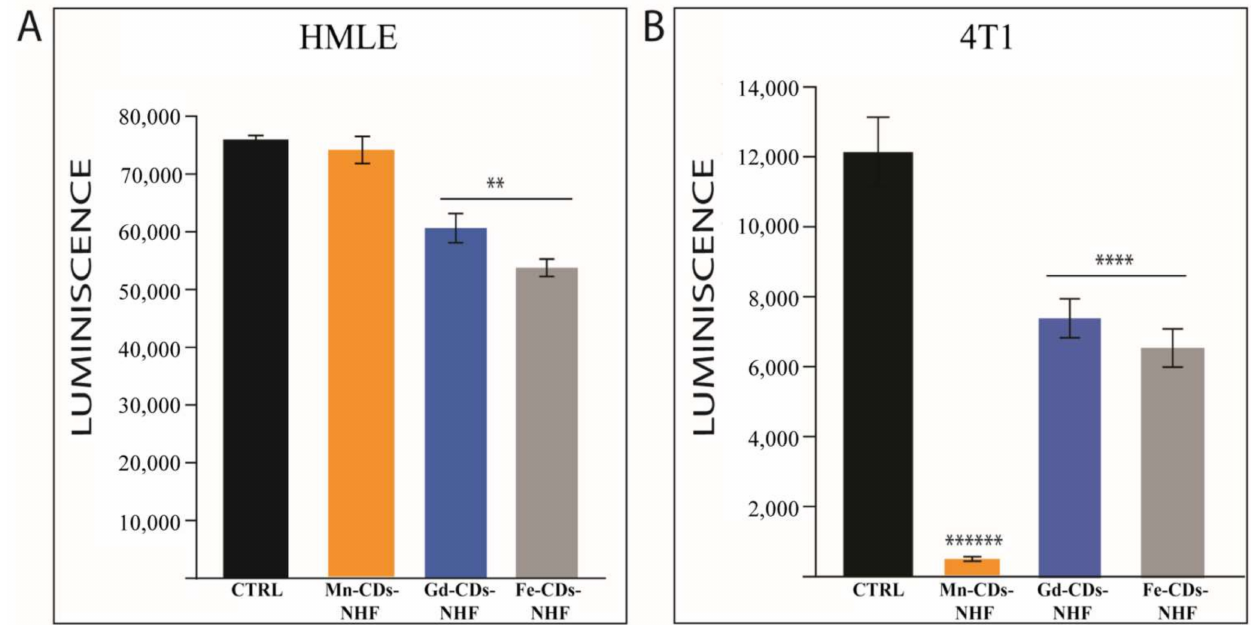
Figure 1. Effects of doped CDs-NHF on cell viability. ( A ). Normal cell line HMLE; ( B ). Cancer cell line 4T1. ** p < 0.05, **** p < 0.0005, ****** p <